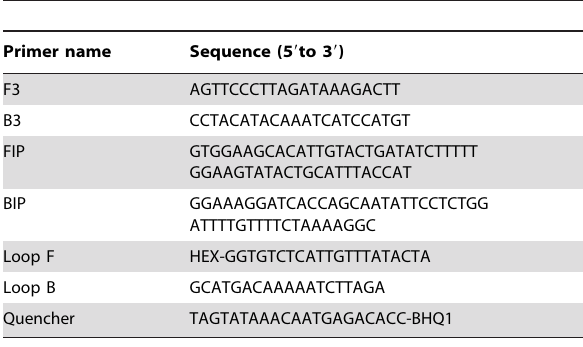
Table 1. Sequence of HIV-1 reverse transcriptase-specific RT- LAMP